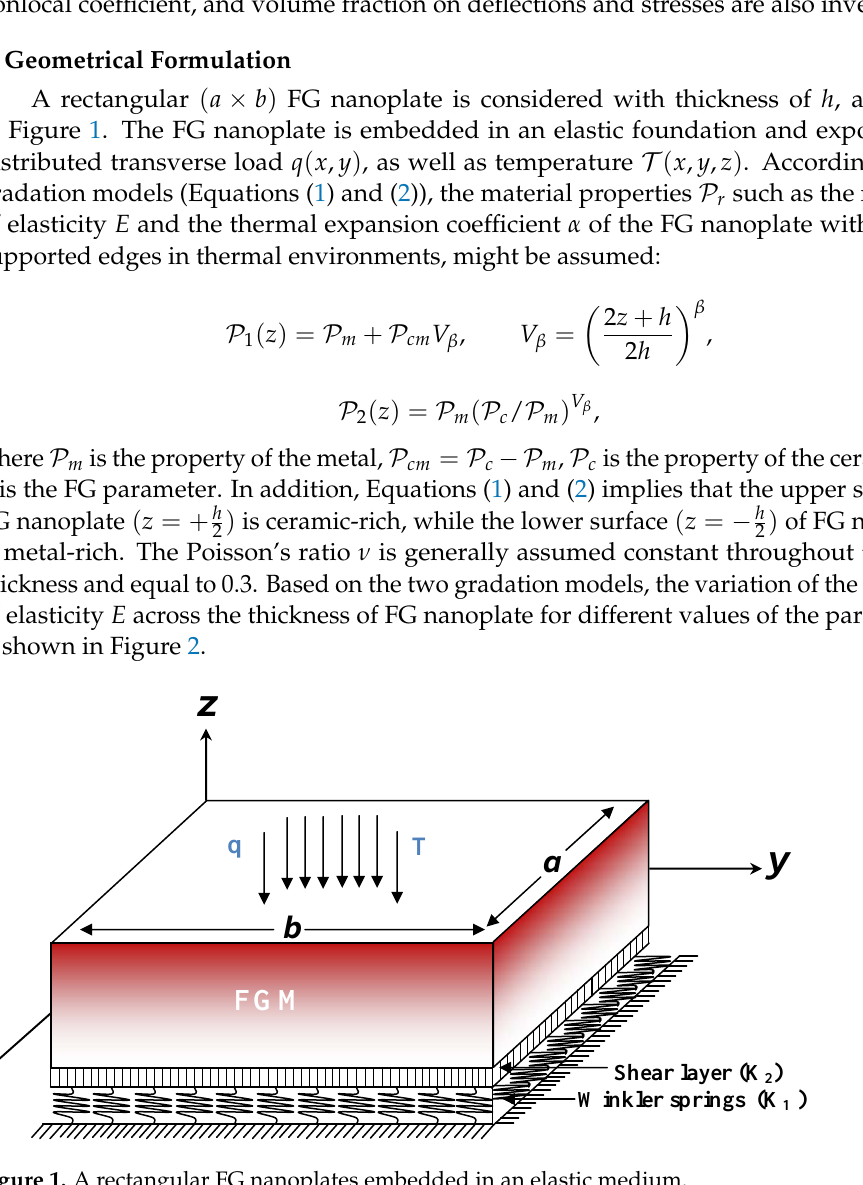
Figure 1. A rectangular FG nanoplates embedded in an elastic